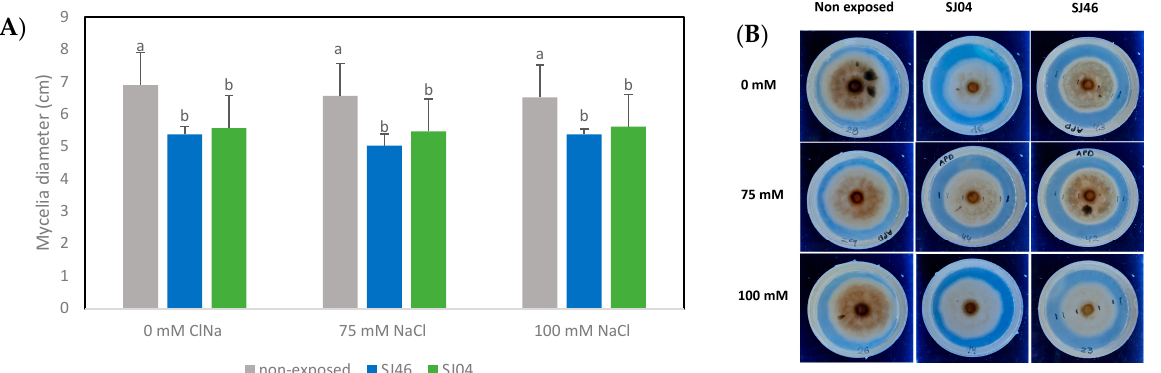
Figure 2. Effects of exposure to SJ46 and SJ04 mVOCs of P. putida on root dry weight of M. piperita plants grown in Murashige–Skoog medium with 0, 75 and 100 mM NaCl. Values are mean ± standard error (SE). Means followed by the same letter in a given column are not significantly different according to Fisher’s LSD test ( p < 0.05).